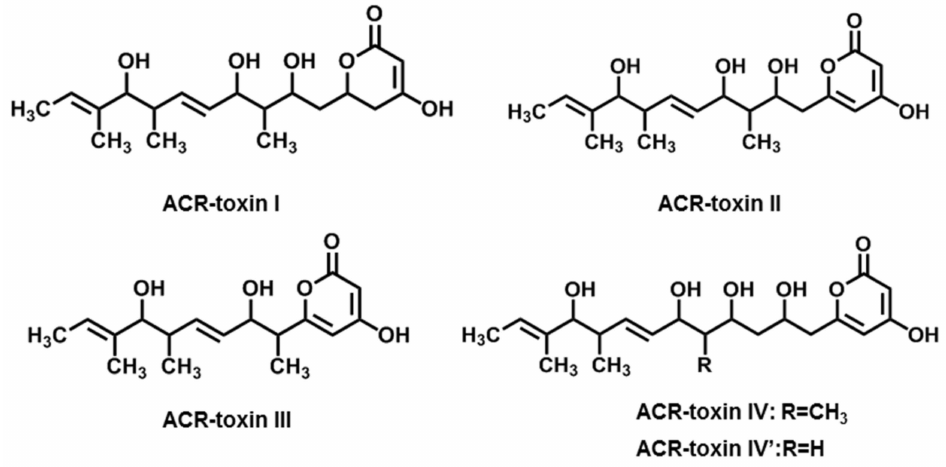
Figure 3. Chemical structures of